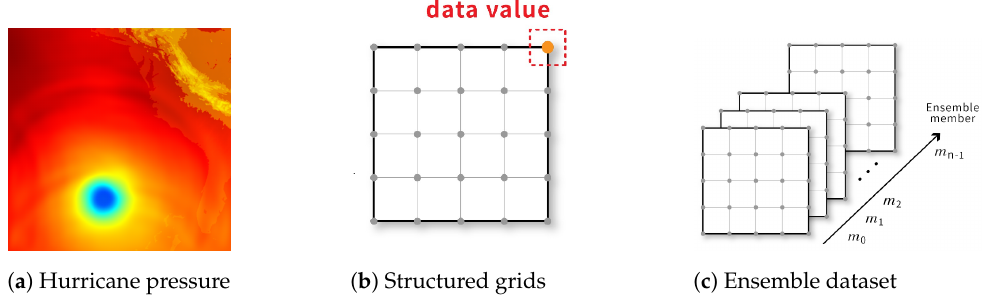
Figure 1. ( a ) is the visualization of a 2D slice of a 3D hurricane pressure dataset; ( b ) is the illustration of the corresponding grid structure of ( a ) and the pressure values are stored at grid points; ( c ) is an illustration of an ensemble dataset. In this example, we have n ensemble members and each ensemble member is a volume data or vector data from the same simulation.